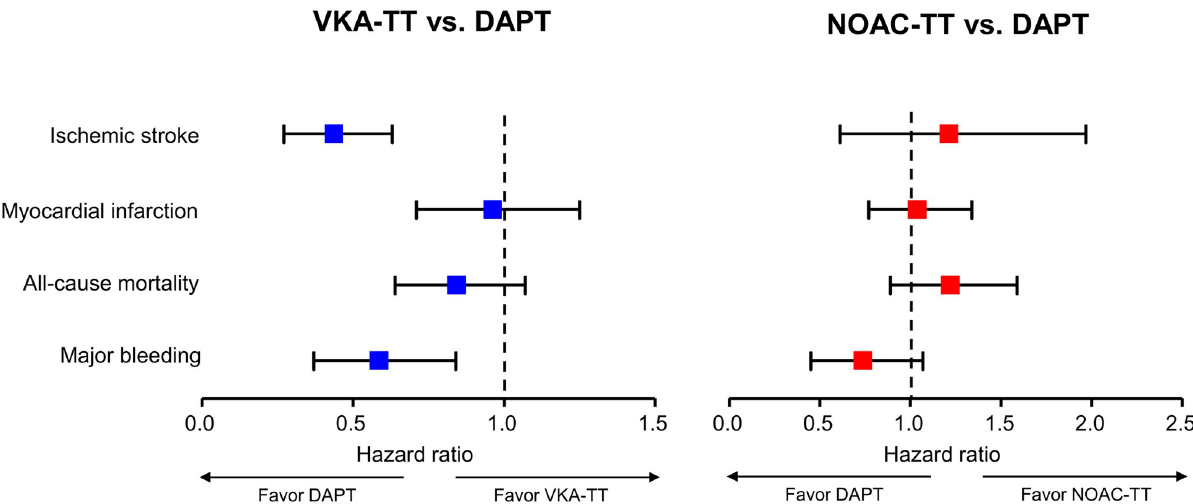
Fig 3. Hazard ratios for ischemic and bleeding risks at 3 months according to antithrombotic therapy. The forest plots represent the ischemic and bleeding risks at 3 months post-PCI of the DAPT compared to the triple therapy based on VKA (left panel) or NOAC (right panel). The DAPT group showed a lower risk of ischemic stroke and major bleeding than the VKA-TT group. In contrast, the DAPT group demonstrated no significant differences in the risks of ischemic and bleeding endpoints compared to the NOAC-TT group. CI, confidence interval; DAPT, dual antiplatelet therapy; NOAC, non-vitamin K oral anticoagulants; PCI, percutaneous coronary intervention; TT, triple therapy; VKA, vitamin K antagonists.